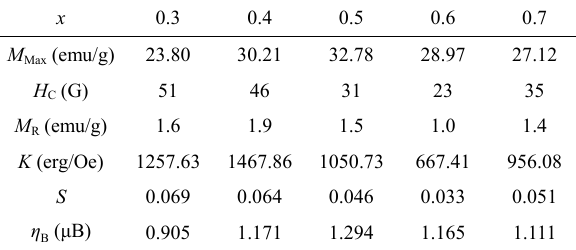
Table 7 M Max , H C , M R , K , S , and η B calculated for Mg